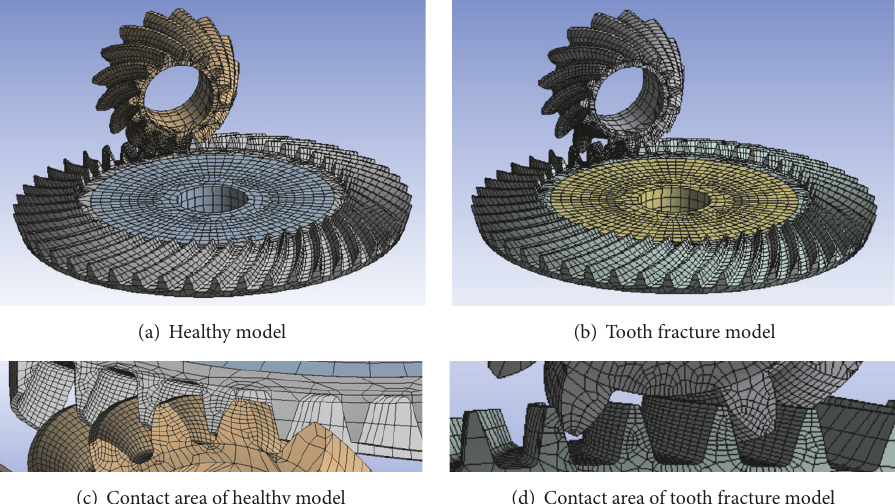
Figure 3: Spiral bevel gear